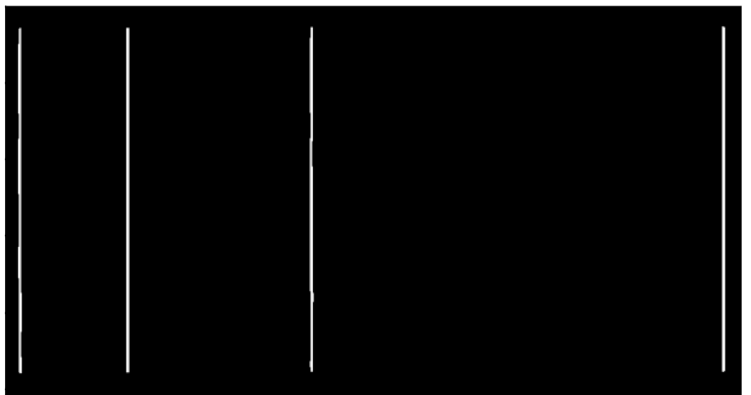
Figure 5. Binary image with vertical lines.